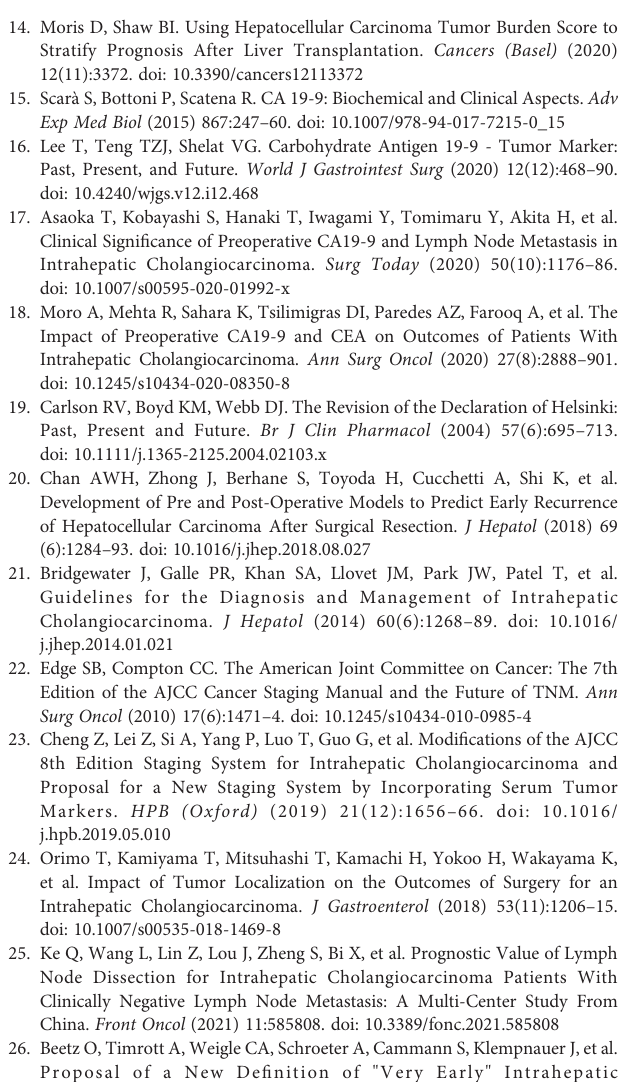
Supplementary Figure 1 | Kaplan-Meier curves for 2-year OS (A) and early recurrence (B) strati fi ed by CTC grade in the derivation cohort. OS, overall survival. Supplementary Figure 2 | Comparison of the predictive value of TBS, CA19-9 and CTC grade in 2-year OS (A) and early recurrence (B) in the derivation